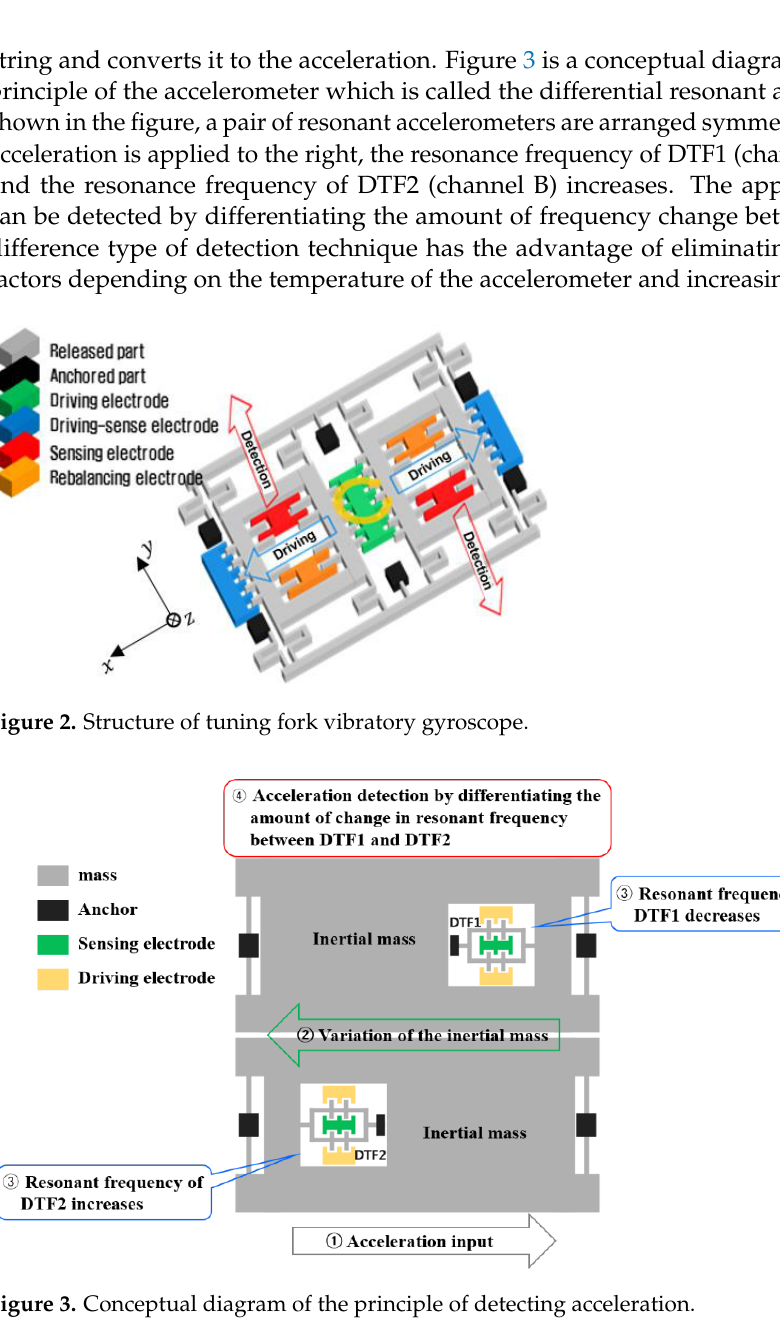
Figure 2. Structure of tuning fork vibratory gyroscope.